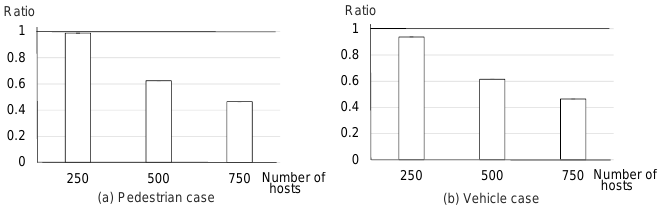
Figure 17. Ratio of cellular traffic in the proposed method to cellular traffic in the existing method.